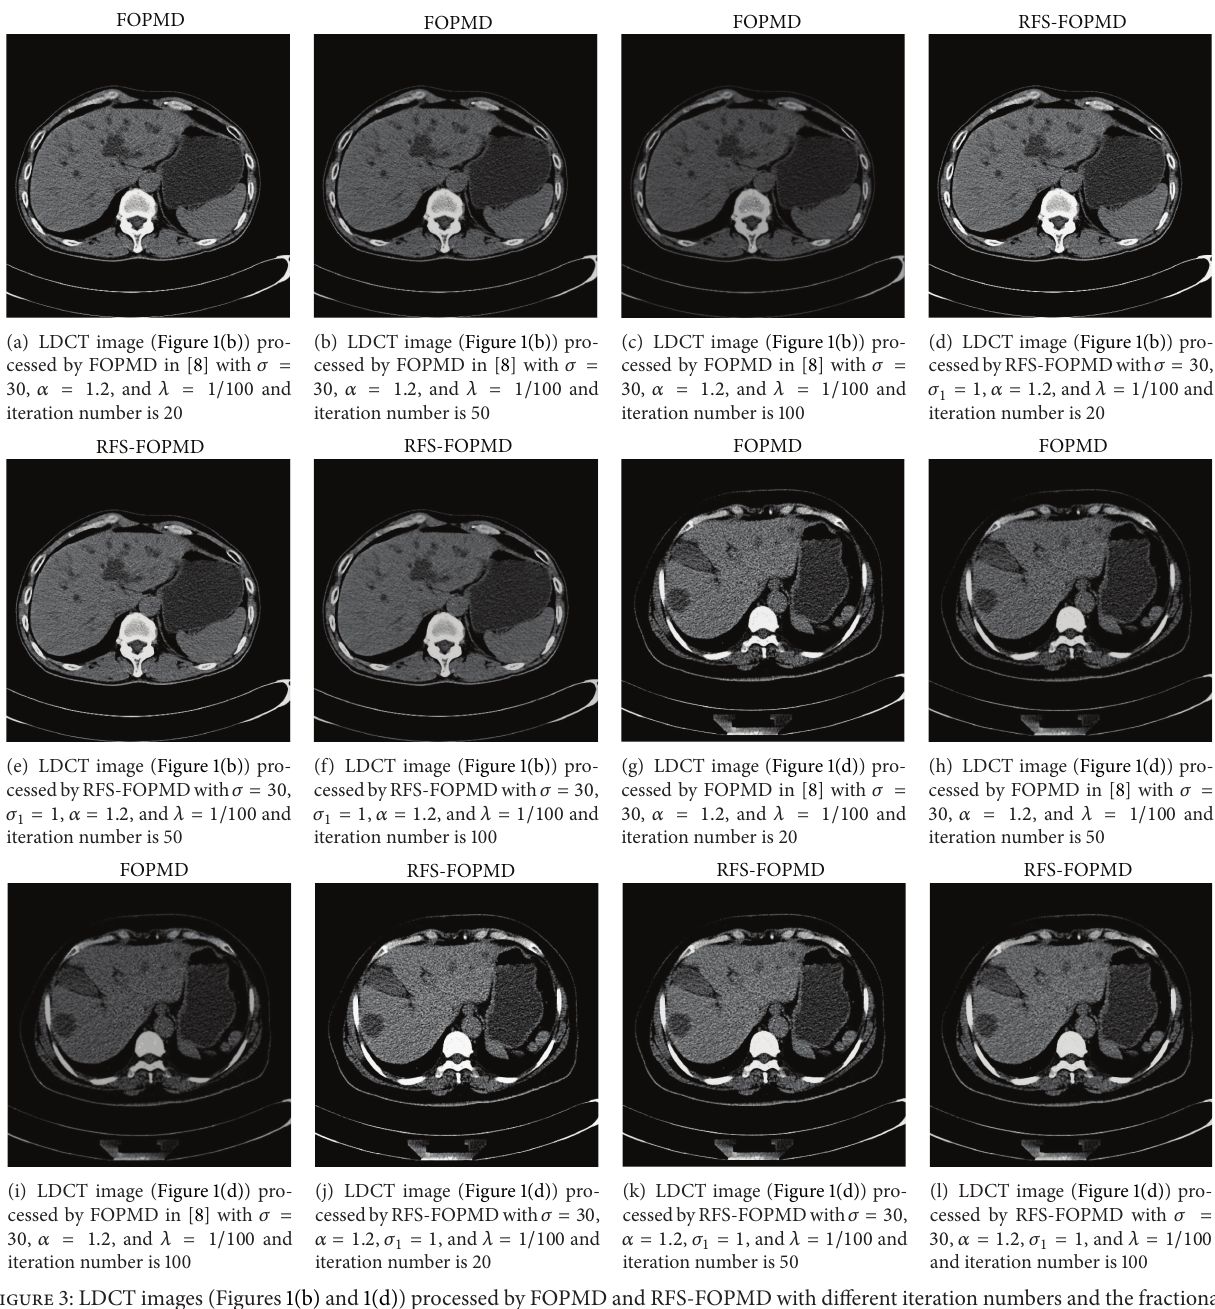
Figure 3: LDCT images (Figures 1(b) and 1(d)) processed by FOPMD and RFS-FOPMD with different iteration numbers and the fractional- order 𝛼 = 1.2 . The first column: iteration number is 20; the second column: iteration number is 50 and the third column: iteration number is 100. The first row: Figure 1(b) processed by FOPMD; the second row: Figure 1(b) processed by RFS-FOPMD; the third row: Figure 1(d) processed by FOPMD and the fourth row: Figure 1(d) processed by